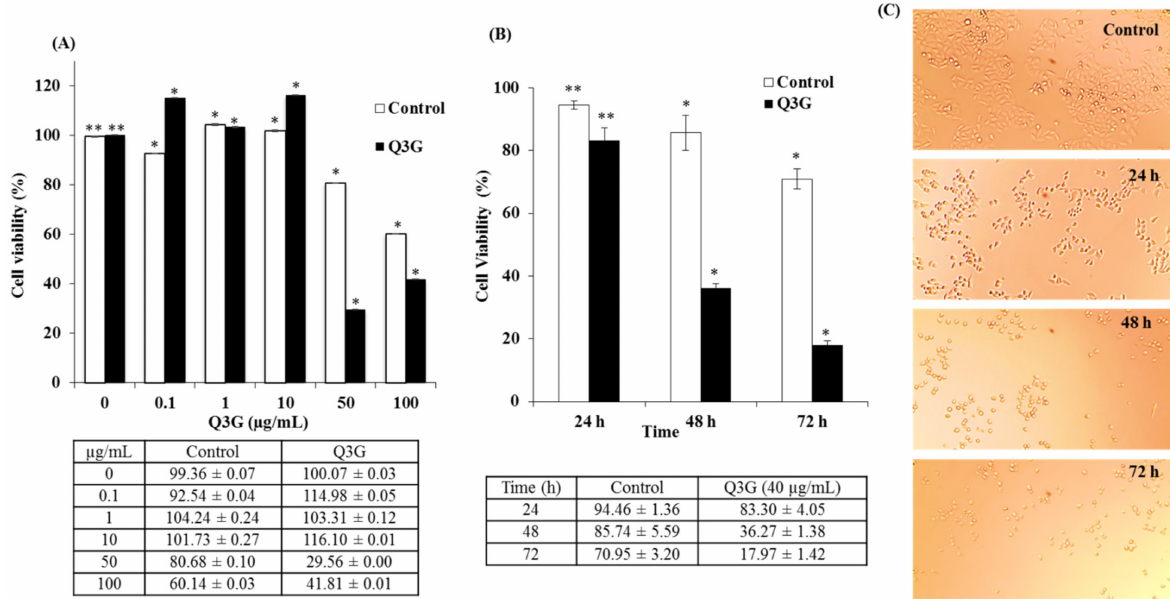
Figure 2. WST assay results for Q3G cytotoxicity in Hela cells: ( A ) Dose dependent cytotoxicity: Cells were treated with different concentrations of Q3G for 48 h. ( B ) Time dependent cytotoxicity: Cells were treated with 40 µ g/mL of Q3G for 24, 48, and 72 h. Data in the table are mean ± SD of two independent experiments in triplicate. ( C ) Phase-contrast images showing the morphological changes in HeLa cells documented after 24, 48 and 72 h of incubation with or without Q3G. * p < 0.05, ** p < 0.01 indicate the significant differences from the